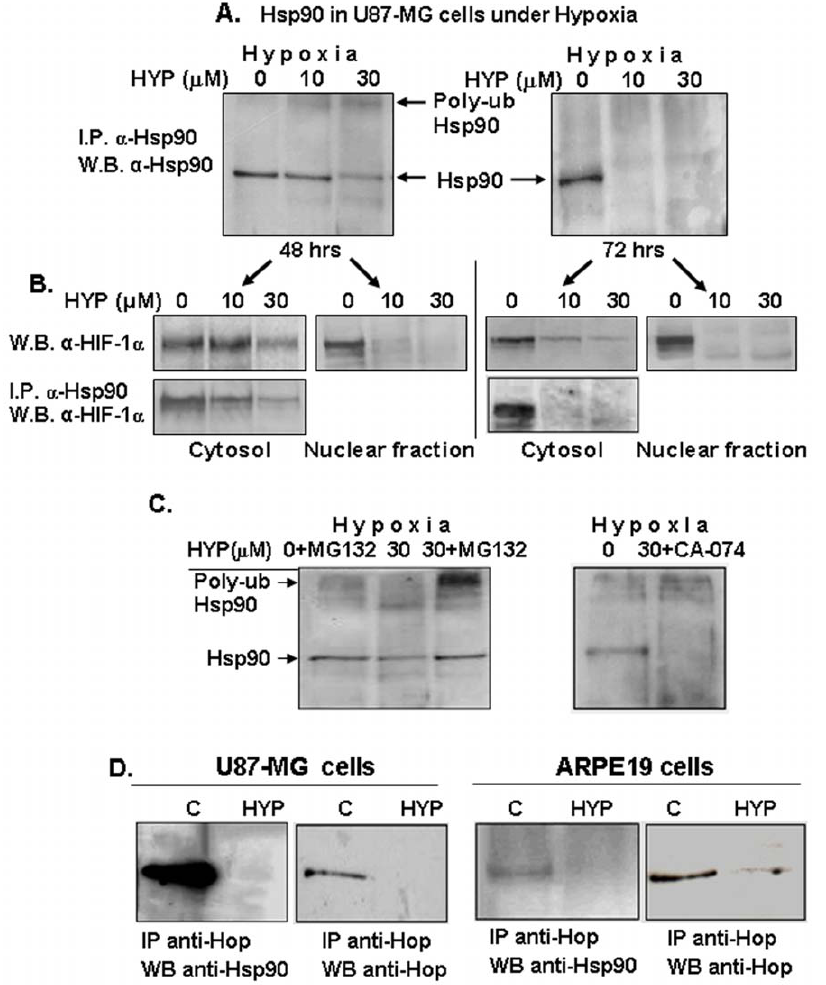
Figure 5. Effects of hypericin-mediated hsp90 poly-ubiquitination on the destabilization of HIF-1 a in U87-MG cells under hypoxia. U87-MG cells were exposed to 10 & 30 m M hypericin for 48 hrs (left panels) and 72 hrs (right panels) under hypoxic conditions (150 m M CoCl 2 ) and hsp90 expression and chaperone activities were analyzed. Cytosolic extracts were immunoprecipitated with anti-hsp90 and Western blots developed with: [A] anti-hsp90 antibodies. [B] anti HIF-1 a . (lower panel), which analyzed hsp90-bound HIF-1 a levels. Bound HIF-1 a levels were compared to total HIF-1 a obtained from Western blots performed on whole cytosolic (left panels) and nuclear extracts (right panels). (HYP denotes hypericin). [C]. Sensitivity of hypericin-induced poly-ubiquitinated Hsp90 to proteasome and cathepsin B inhibitors in U87-MG cells. Left panel – MG132 proteasome inhibitor and right panel CA-074, cathepsin B inhibitor. [D]. Effects of cell treatment with hypericin on formation of Hop co-chaperone-mediated hsp90-hsp70 intermediate complexes. Analyses of Hop content in these complexes: left pair refers to U87-MG cells and right pair to ARPE19 cells.